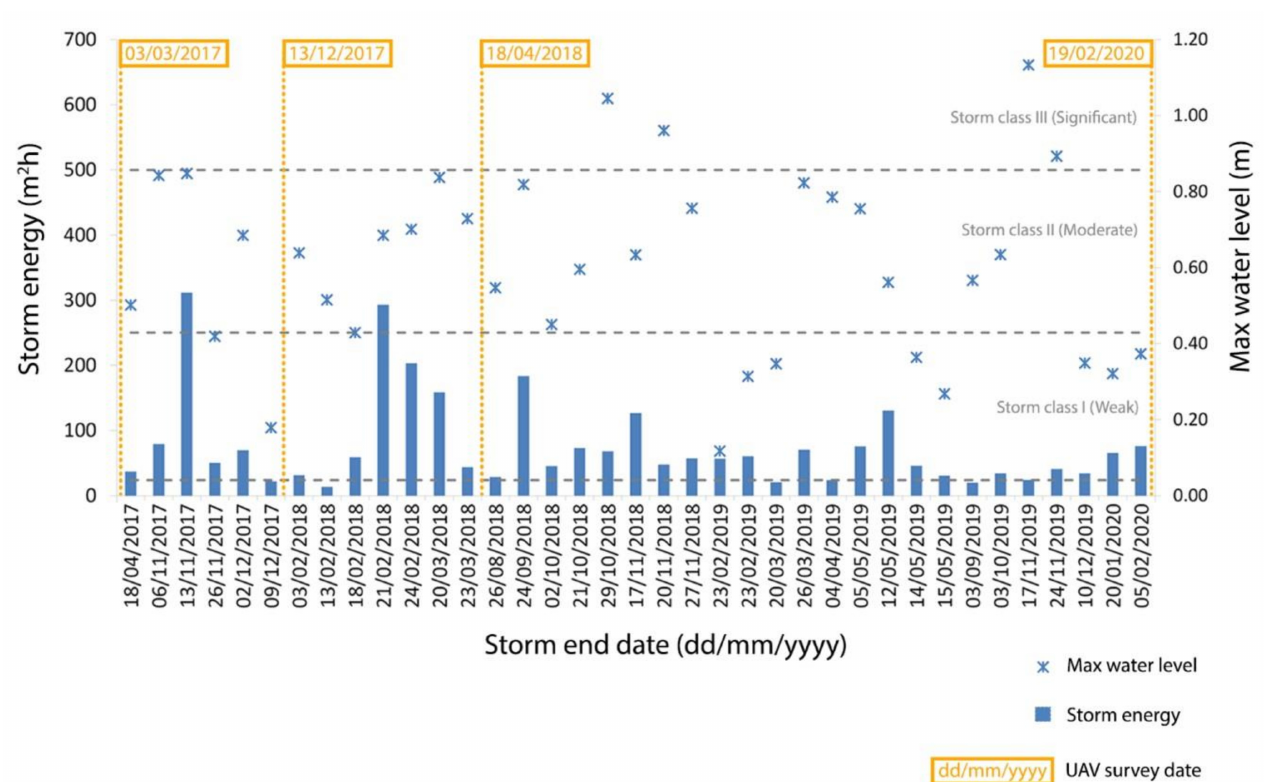
Figure 11. Storms occurred during the period analysed. Storm energy is calculated following the Mendoza et al. (2011) storm classification. The maximum water level is also shown for each storm. Wave and water level data were provided by the local environmental agency